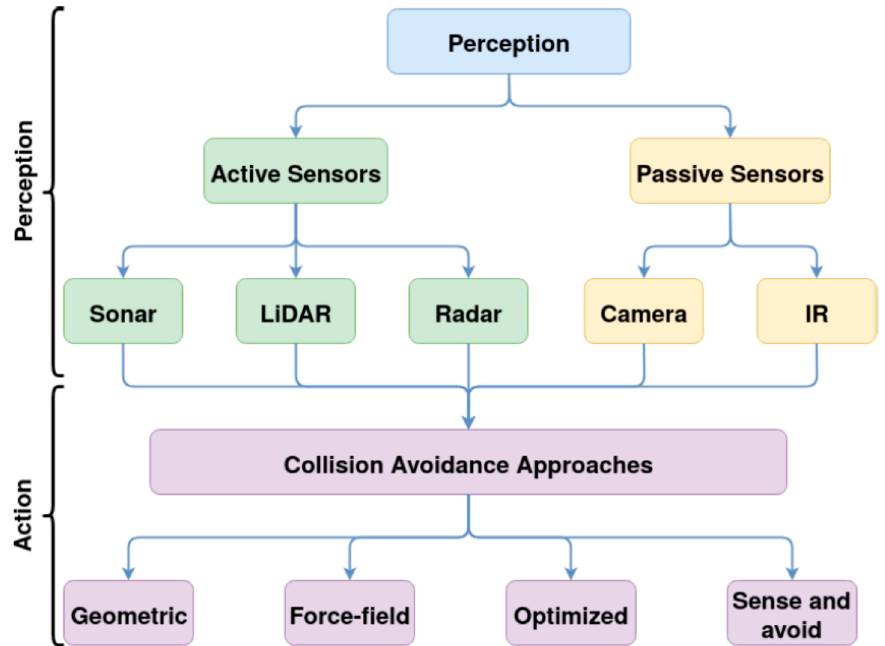
Figure 7. Collision avoidance system generalized modules presented in [59], used with permission under Creative Commons Attribution 4.0 International License.